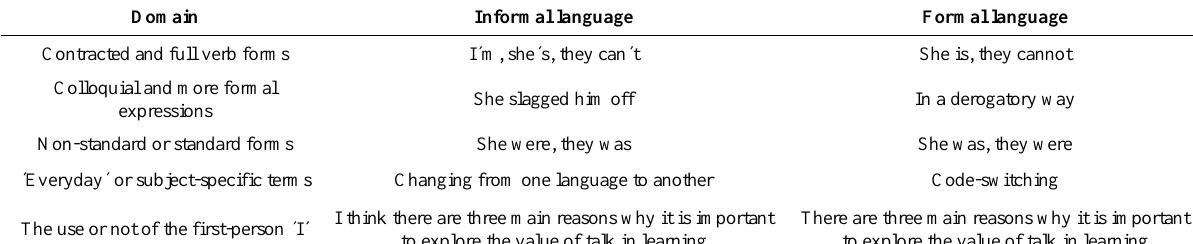
Table 1. Difference between formal and informal language (Adapted from